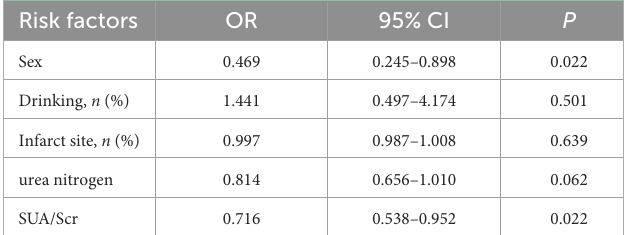
TABLE 3 Multivariate logistic regression analysis results of the factors related to END.